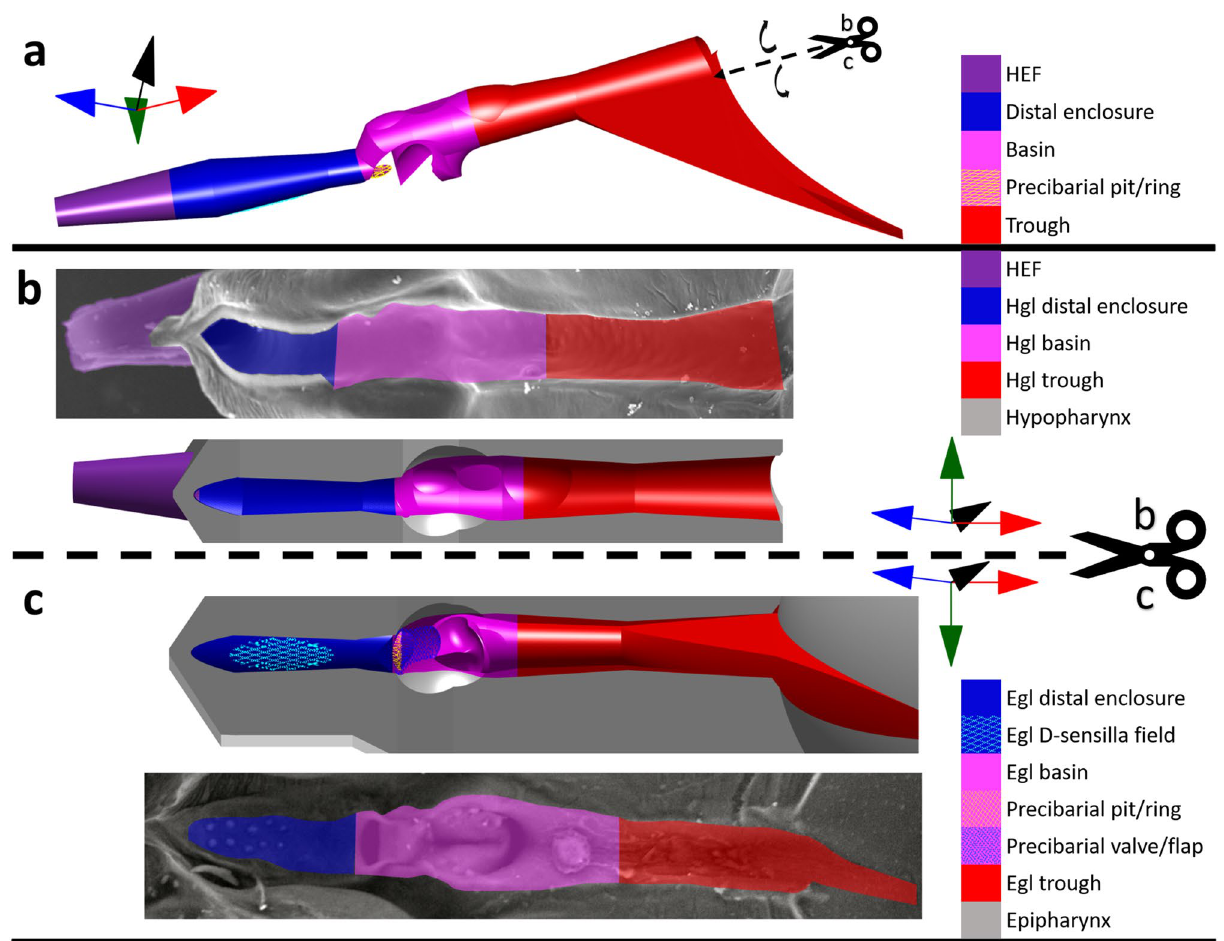
Figure 3. Close-up segments of the precibarium of the blue–green sharpshooter, labeled with broad terminology. ( a ) Precibarium 3D model segment. It shows an external view of the walls of the precibarium, as if the rest of the epipharynx and hypopharynx didn’t exist (convex). ( b ) Hypopharyngeal precibarial walls (colored, concave) in electron microscope image of a segment of the hypopharynx (top, internal) and equivalent view of the 3D model segment (bottom, concave) for comparison. ( c ) Epipharyngeal precibarial walls 3D model segment (top, mostly concave) and an equivalent electron microscope image (bottom, mostly concave) for comparison. The coordinate axes indicate anterior → posterior, distal → proximal (for the trough), ventral → dorsal, and left → right. The scissors and dotted lines indicate where the 3D model segment in subfigure a would be split to obtain the 3D model segments in subfigures b and c. The associated black curved arrows indicate that the two halves of the split 3D model segment would need to be hinged outward to obtain the views in subfigures b and c. The gray 3D parts of subfigures b and c are semi-abstract representations of the epipharynx and hypopharynx, which serve for comparison with their corresponding electron microscope images. Hgl: hypopharyngeal; egl: epipharyngeal; HEF: hypopharyngeal extension that inserts into the stylet food